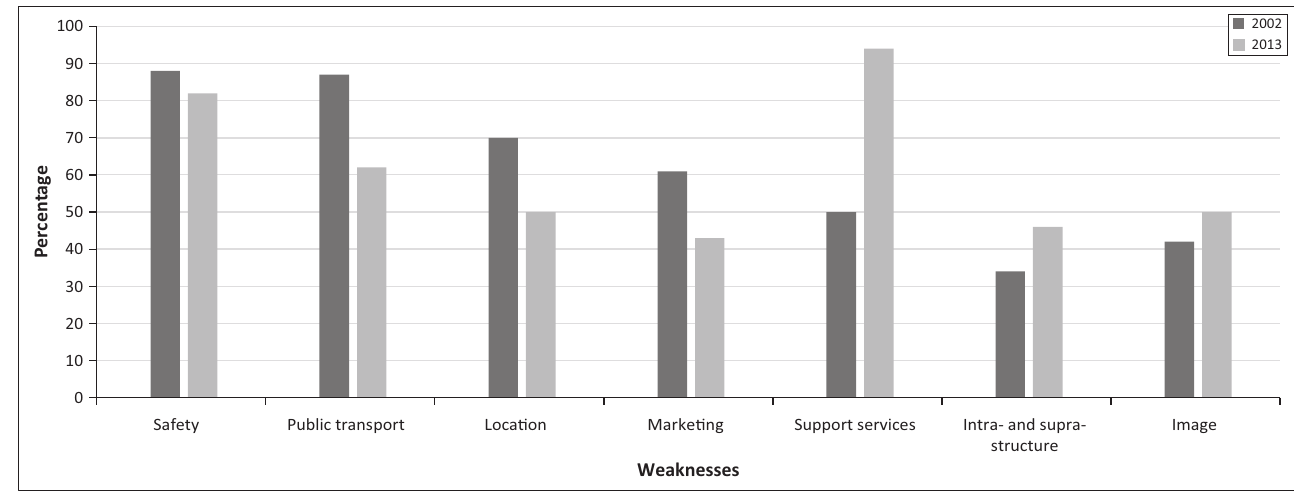
FIGURE 4: Comparison of South Africa’s main strengths in 2002 and 2013.